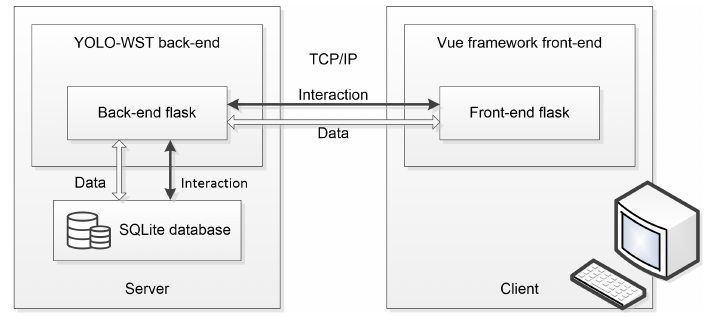
Figure 17. Software architecture.